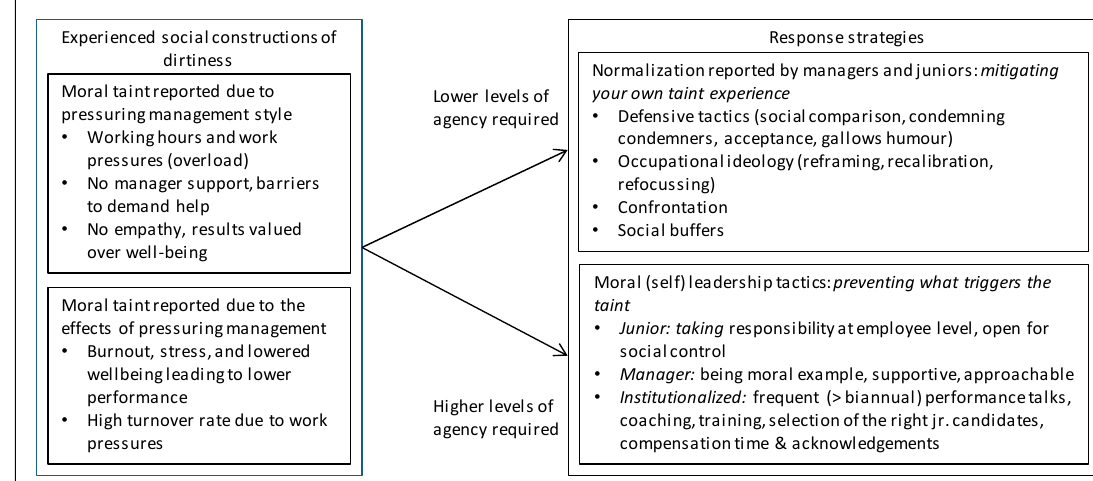
Figure 1. Moral taint constructions linked to management, and response strategies.